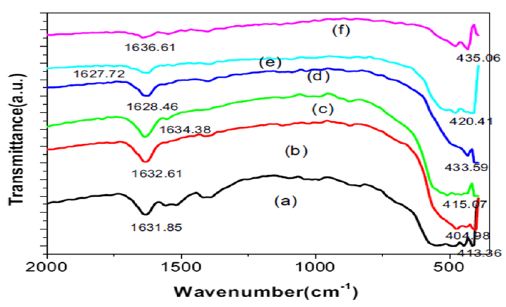
Fig. 13 FTIR spectra of wurtzite nanoparticles ( a ) before and after calcinated temperature at b 300 °C, c 500 °C, d 650 °C, e 700 °C, and f 750 °C (Kayani et al. 2015)